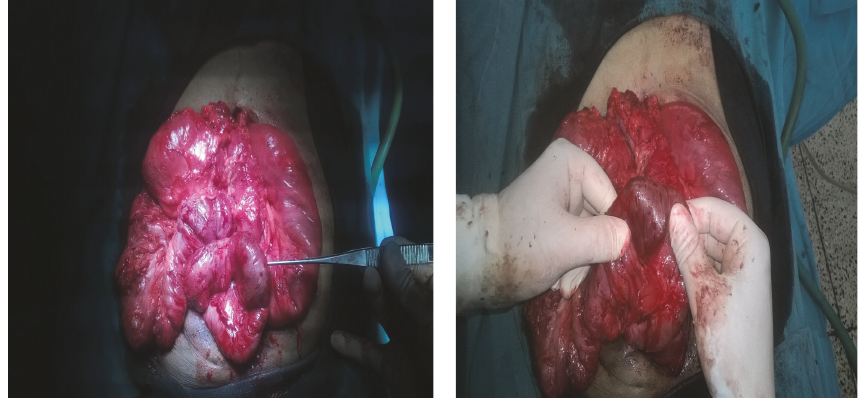
Figure 1: Intraoperative appearance of enterolith impacted in the mid ileum prior to enterotomy with multiple dense adhesions and bands.